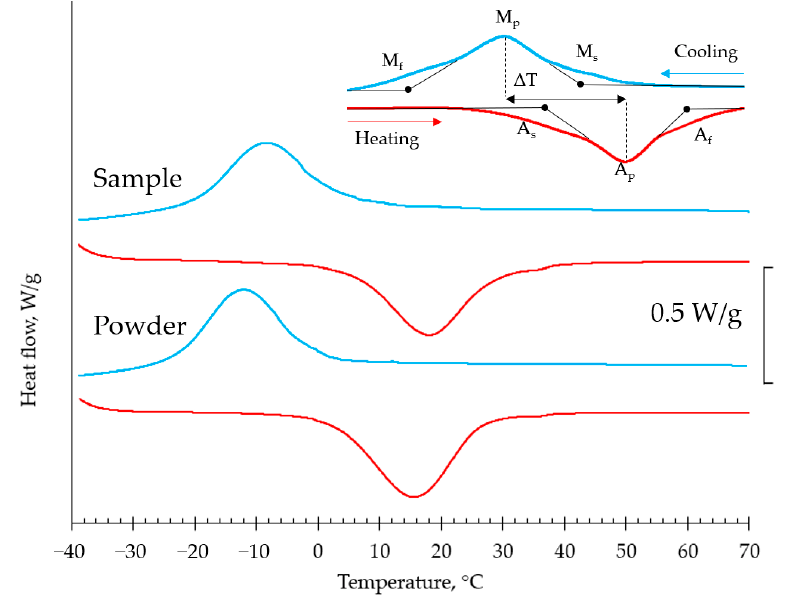
Figure 12. Differential scanning calorimetry for raw powder and sample P100V850. Table 2. Temperatures of phase martensitic transition of initial powder material and fabricated sample.